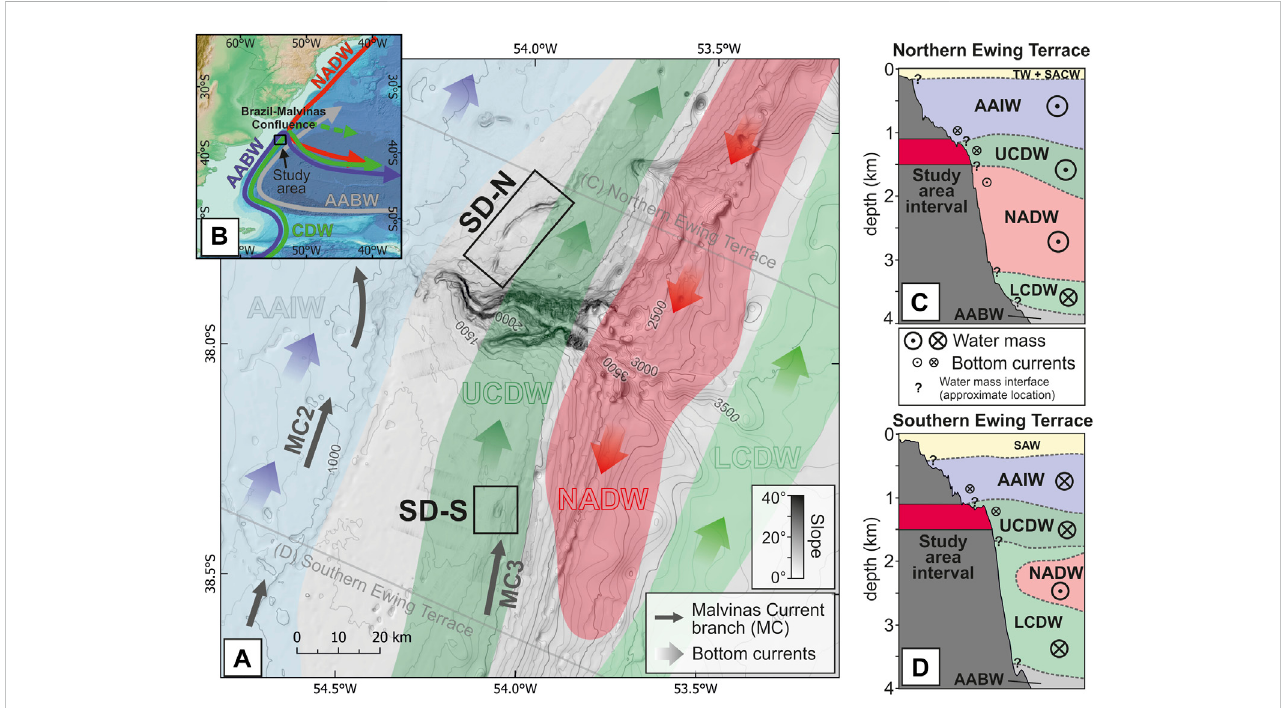
FIGURE 2 Oceanographic setting of the study area. (A) Spatial extent of modern-day near-bottom water masses (adapted from Preu et al., 2013; Steinmann et al., 2020)showingareaswithoutadistinctwatermasscorrelation(grey)forSD-NandupslopeofSD-S.Dominant fl owdirectionsofmodern-daybottomcurrents (colored arrows) and the locations of two branches of the Malvinas Currents (MC, dark grey arrows) are adapted from Wilckens et al. (2021a). (B) Schematic overview of intermediate and deep-water circulation along the southwest Atlantic margin (adapted from Warratz et al., 2019; Wilckens et al., 2021a). Generalized schematic oceanographic sections alongthenorthernArgentine continental margin, (C) north and (D) south oftheMardel PlataCanyon, display the vertical strati fi cation of the water column and fl ow directions along the margin (based on Piola et al., 2001; Hernández-Molina et al., 2009; Preu et al., 2012; Wilckens et al., 2021a). Depth range of the study area on the Ewing Terrace is highlighted in red. For simplicity, only the approximate positions of water mass interfaces are indicated (question marks). TW, Tropical Water; SACW, South Atlantic Central Water; AAIW, Antarctic Intermediate Water; UCDW,